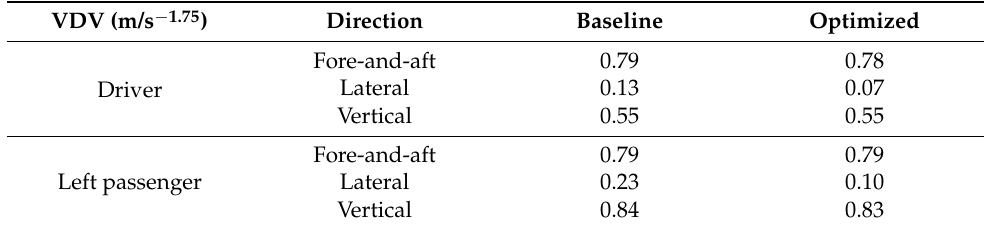
Table 3. Comparison of VDVs between the baseline and the optimized bushings.